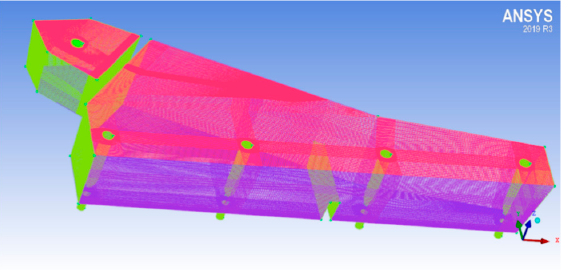
Figure 4. Computational domain of the tundish for numerical simulation.